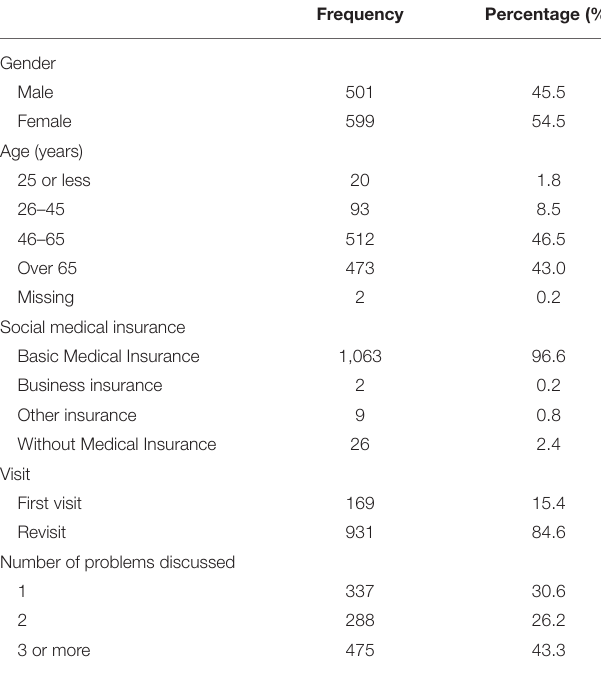
TABLE 1 | Patient characteristics ( N = 1,100). TABLE 2 | Patient reasons for encounter and problems by ICPC-2